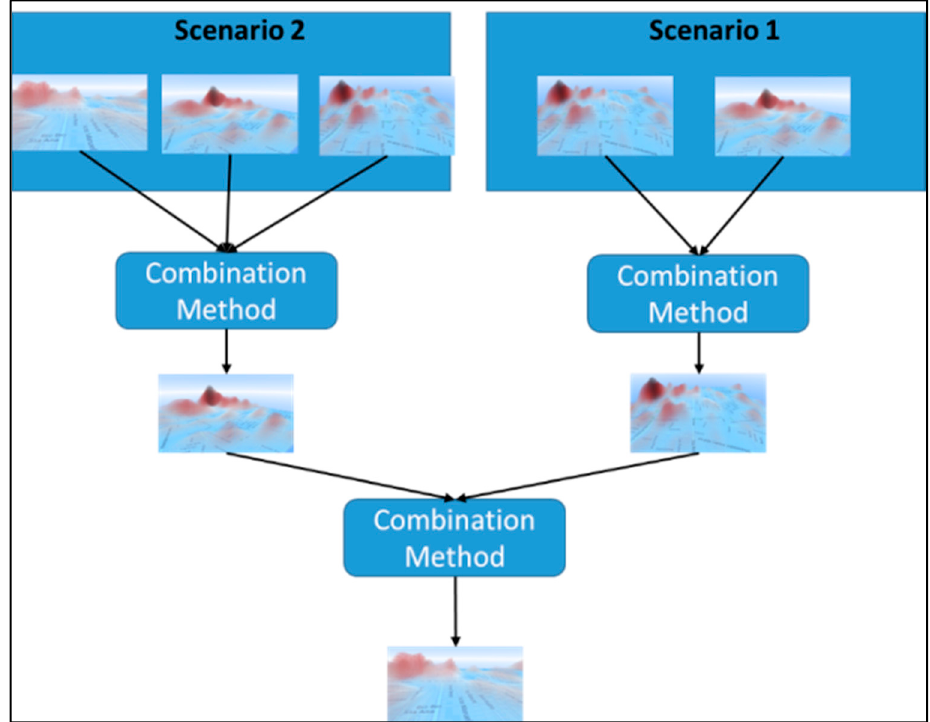
Figure 2. Hierarchical combination